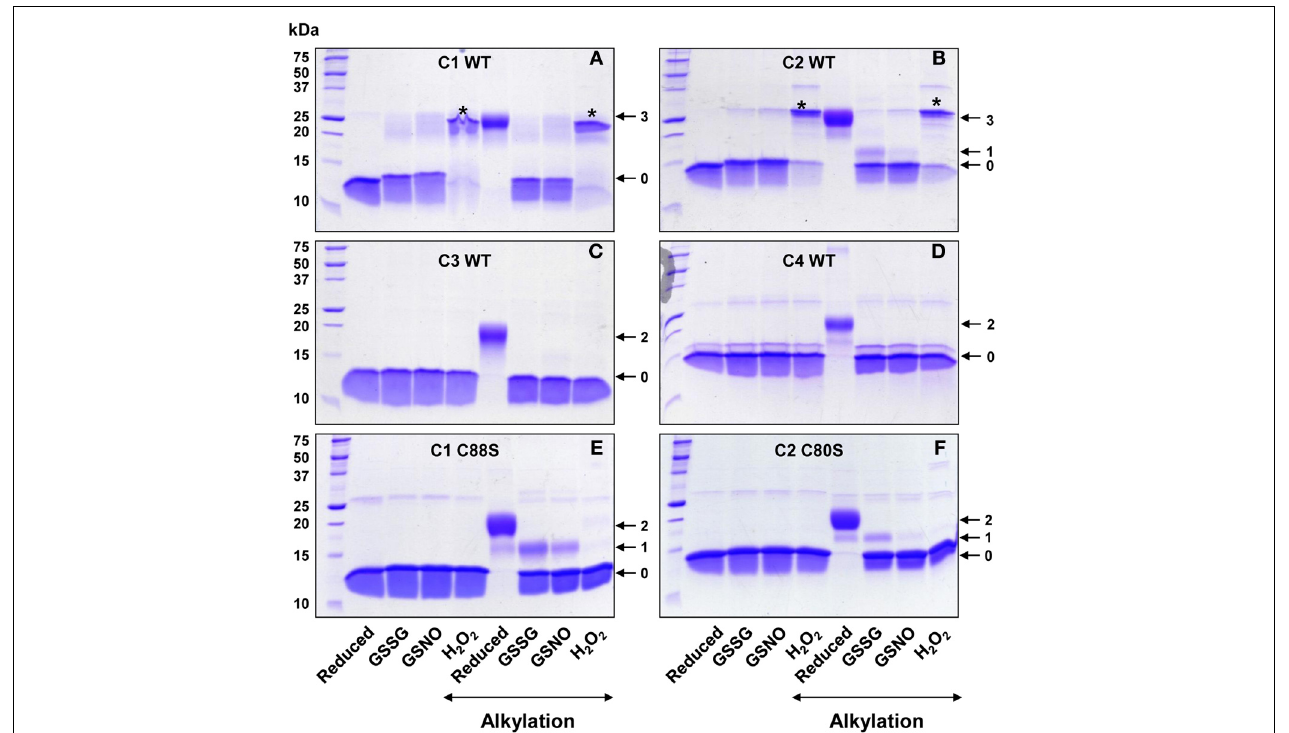
FIGURE 3 | Sensitivity of poplar Grxs to oxidative treatments. Pre-reduced Grxs were subjected to 2h oxidative treatments with H 2 O 2 , GSSG, and GSNO as described in the “materials and methods” section. Prior to separation on SDS-PAGE gels in non-reducing conditions, GrxC1 WT (A) , GrxC2 WT (B) , GrxC3 WT (C) , GrxC4 WT (D) , GrxC1 C88S (E) , and GrxC2 C80S (F) were alkylated or not with 2kDa mPEG maleimide. The shift